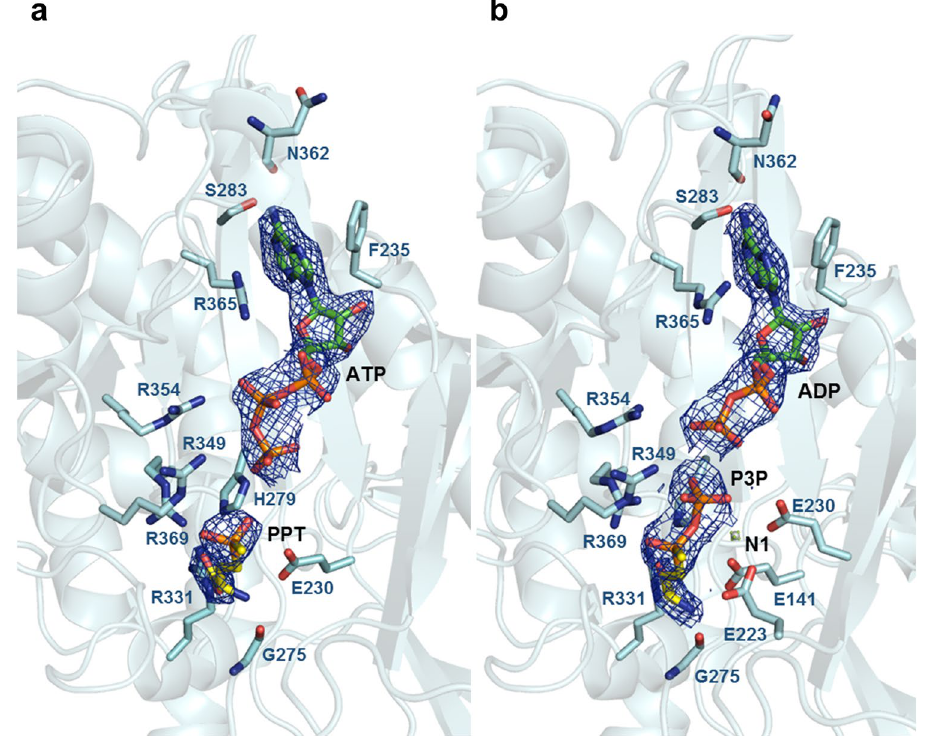
Figure 3. Active site of Hpy GS. ( a ) The active site of Hpy GS sub with ATP and PPT. ( b ) The active site of Hpy GS int with ADP and P3P. The N, H, and O atoms of the ligands are coloured in blue, grey, and red, respectively. The C atoms of Hpy GS, ATP/ADP, and PPT/P3P are presented in light blue, green, and yellow, respectively. The 2 Fo-Fc maps of ATP/ADP and PPT/P3P are shown.